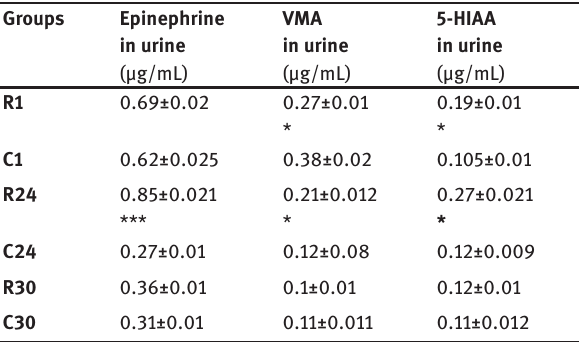
Table 2: Changes of epinephrine, 5-hydroxyacetic acid and vanillylmandelic acid in urine of experimental groups affected by different degree of intestinal injury (*p<0.05; *** p<0.001) .